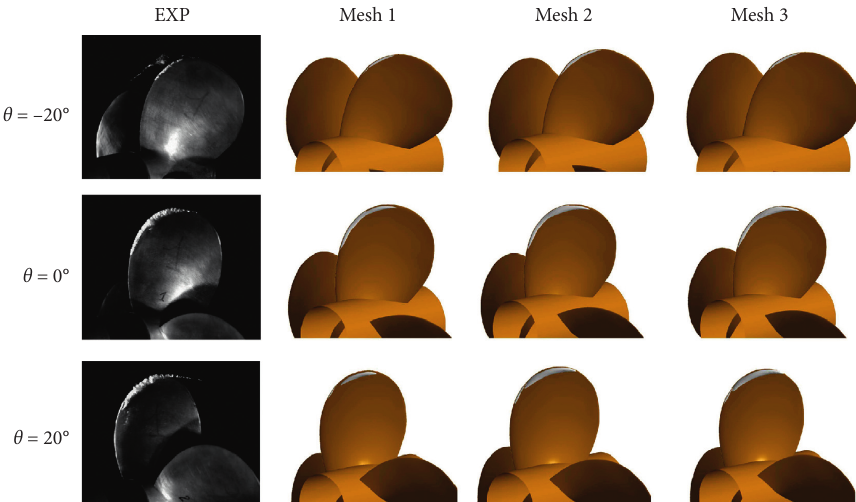
Figure 4: Comparison of the simulated and measured cavitation patterns as the propeller rotation by the three set of meshes [1,